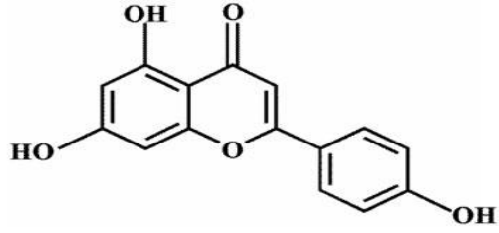
Figure 1. Apigen in’ s chemical structure. Figure 1. Apigenin’s chemical